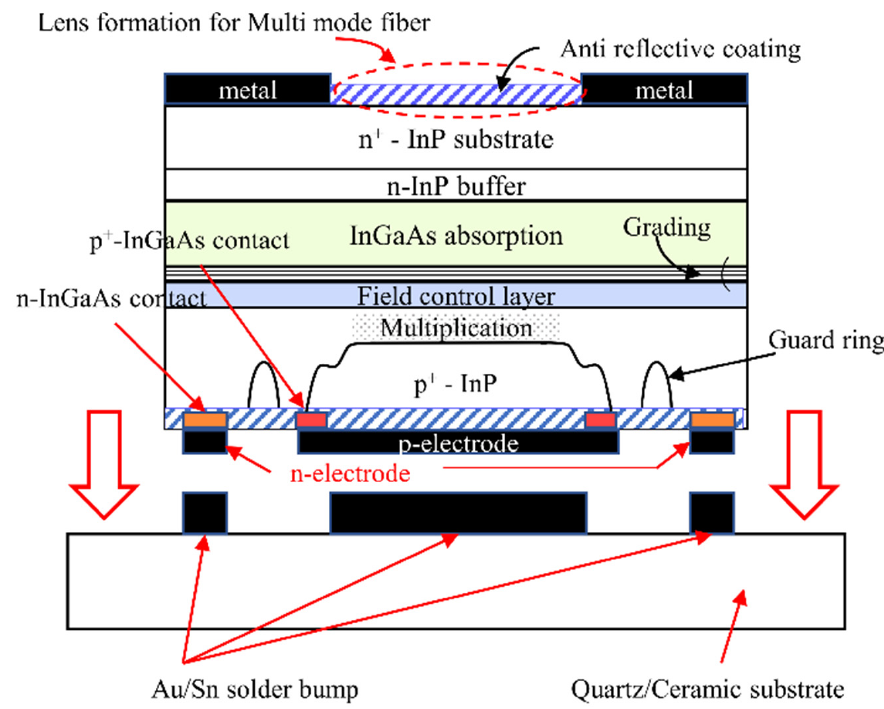
Figure 1. Cross-section of the open-tube diffused 10 Gbps planar InGaAs/InP APD test structure.